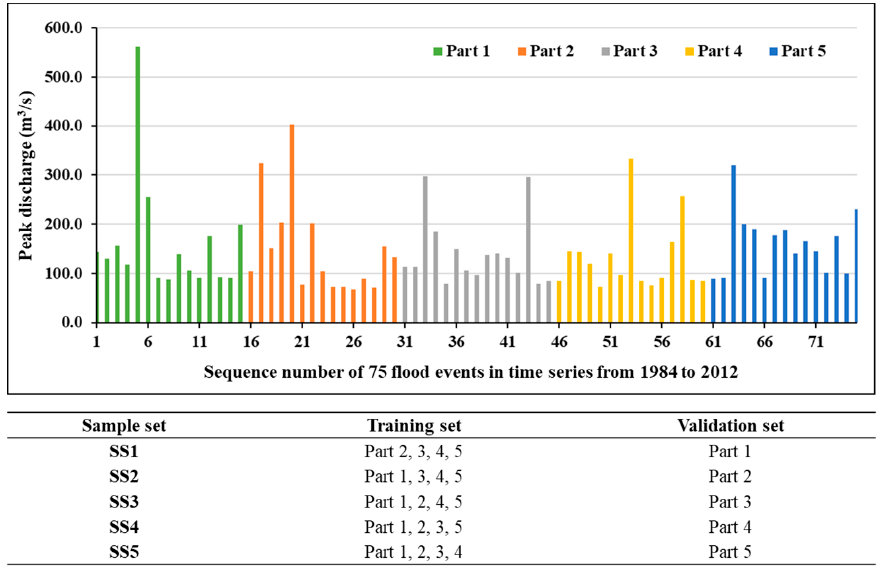
Figure 8. Partition of sample set 1–5.